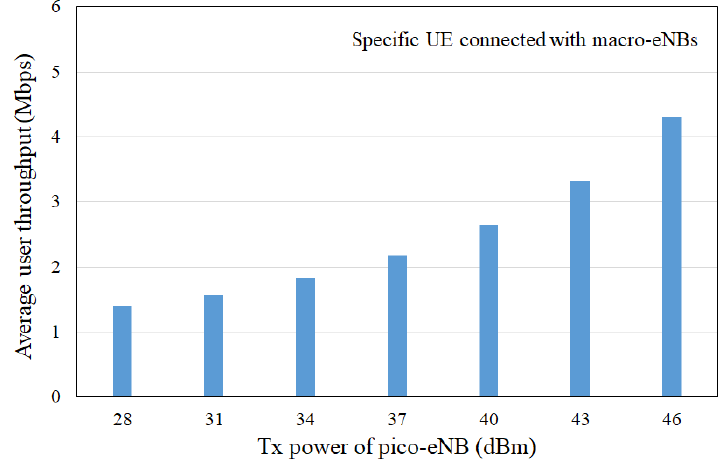
Figure 9. Average user throughput of specific UE connected with macro-eNBs as a function of pico- eNB Tx power.